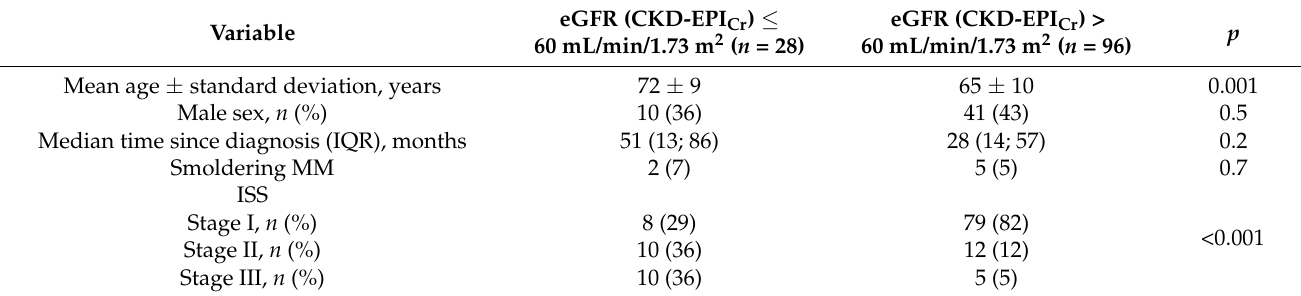
Table 1. Clinical characteristics of the studied patients with